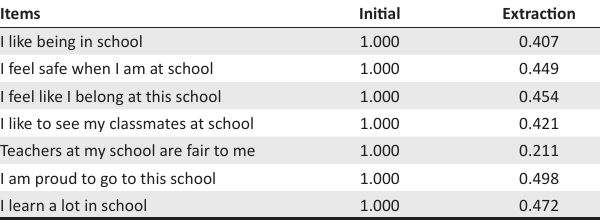
TABLE 1-A1: Communalities from the principal component analysis with the seven items for the index sense of school belonging. Items Initial Extraction